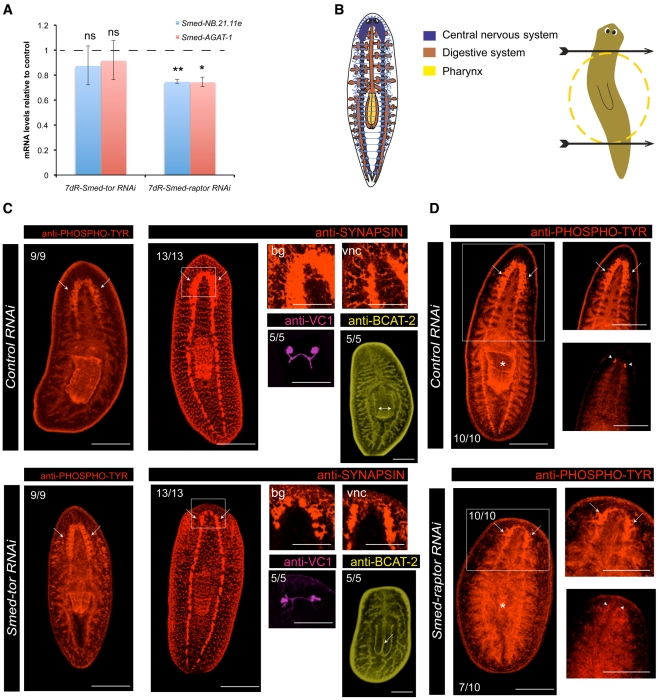

Smed-tor and Smed-raptor show similar levels of neoblast progeny as controls and are able to differentiate structures at anterior wounds.A. Relative expression of cat-2 marker Smed-NB.21.11e and cat-3 marker Smed-AGAT-1 at 7 days of regeneration after either Smed-tor or Smed-raptor RNAi experiments. Expression levels are relative to gfp RNAi injected animals (dotted line). Error bars are s.d from the mean. Asterisks indicate P<0.05 (one asterisk), P<0.01 (two asterisks) and ns indicates “not significant” using two-tailed Student's test with equal sample variance and relative to expression in control animals. B. The cartoon on the left is a representation of the central nervous system (CNS in blue), the digestive system (brown) and the pharynx (yellow) in planarians. The cartoon on the right shows the levels of transverse amputation performed in the experiment (arrows) and highlights the trunk piece (dotted red circle), which was kept to follow anterior and posterior regeneration in all the experiments. C. The panels show staining for different markers of differentiation in the anterior wounds in control and Smed-tor RNAi animals. Anti-PHOSPHO-TYROSINE labels the CNS, digestive system, pharynx and eyes. The arrows highlight the presence of brain ganglia in both control and Smed-tor RNAi at anterior wounds in 12 dR trunks. Anti-SYNAPSIN labels the synapses at the CNS. The white square indicates that this region is magnified in the panels in the right and highlights the presence of brain ganglia in both control and Smed-tor, however underdeveloped in Smed-tor RNAi 7 dR trunks. bg, brain ganglia; vnc, ventral nerve cords. Anti-VC1 staining shows that controls and Smed-tor RNAi animals have differentiated eyes at the anterior wound site at 12 dR trunks. Anti-BCAT-2 staining shows that the lumen of the pharynx in Smed-tor RNAi animals is reduced (double arrow) compared to controls (arrow). D. Panels show 15 dR trunks. The panels show staining for anti-PHOSPHO-TYROSINE as a marker for CNS, digestive system and eyes in the anterior wounds of control and Smed-raptor RNAi animals. The white square indicates that this region is magnified in the panels in the right and highlights the presence of brain ganglia in both control and Smed-raptor RNAi animals (arrows), however underdeveloped in Smed-raptor RNAi animals (10/10). Arrowheads indicate the presence of eyes. The asterisk indicates the position of the pharynx, which is disorganized in Smed-raptor RNAi animals compared to controls (7/10). Scale bars indicate 300 µm.